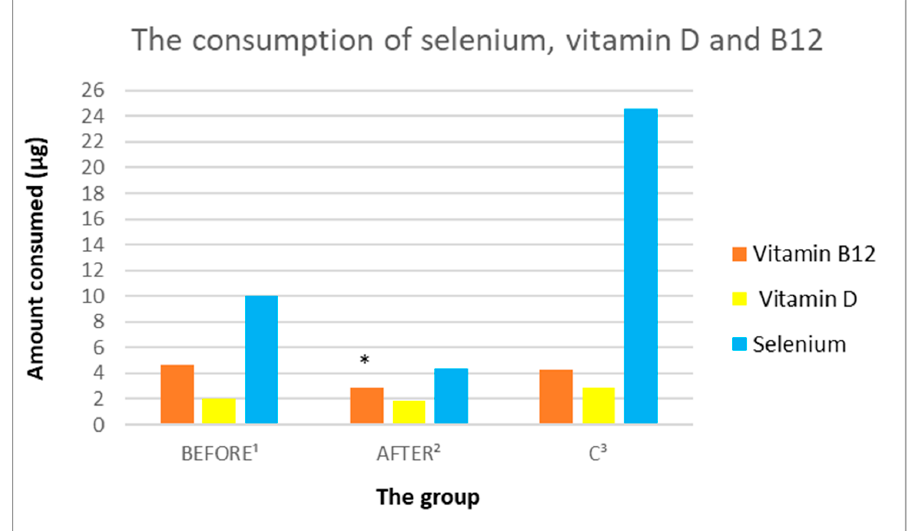
Figure 11. Average daily intake of vitamin D, B12, and selenium by groups. ¹ study group prior to ketamine administration; ² study group after administration of ketamine; ³ control group; * indicates a statistically significant result p < 0.05 in the group after administration of ketamine, compared to the control group.